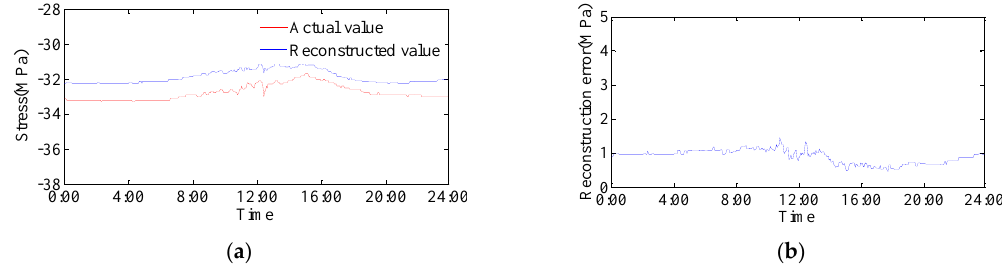
Figure 4. The comparison between the reconstructed value and the actual value: ( a ) the curve of reconstructed value and the actual value; and ( b ) the curve of absolute error.